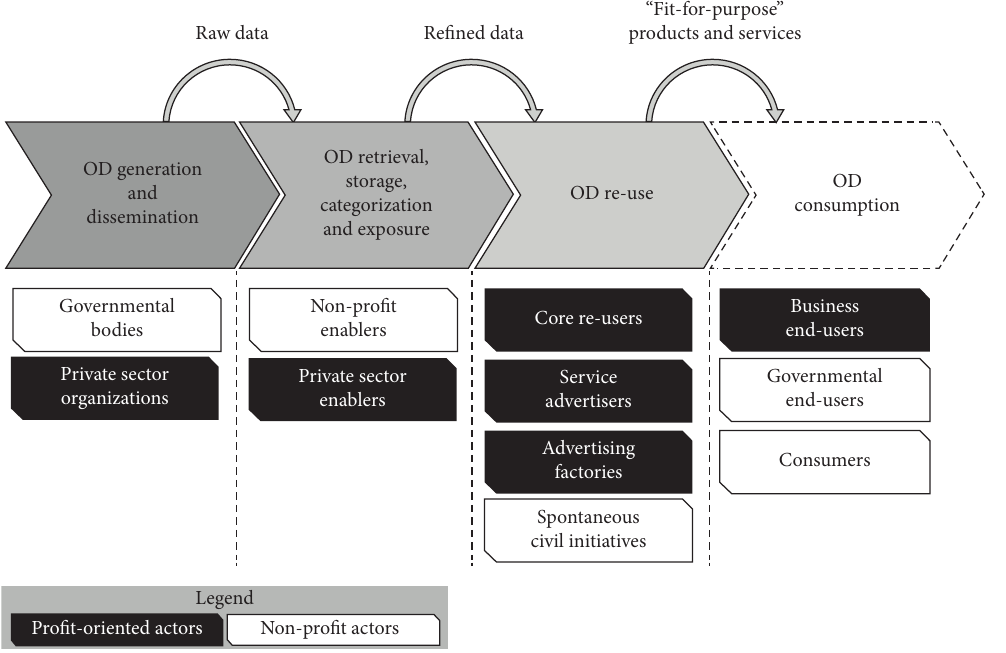
Figure 1: Open data value chain